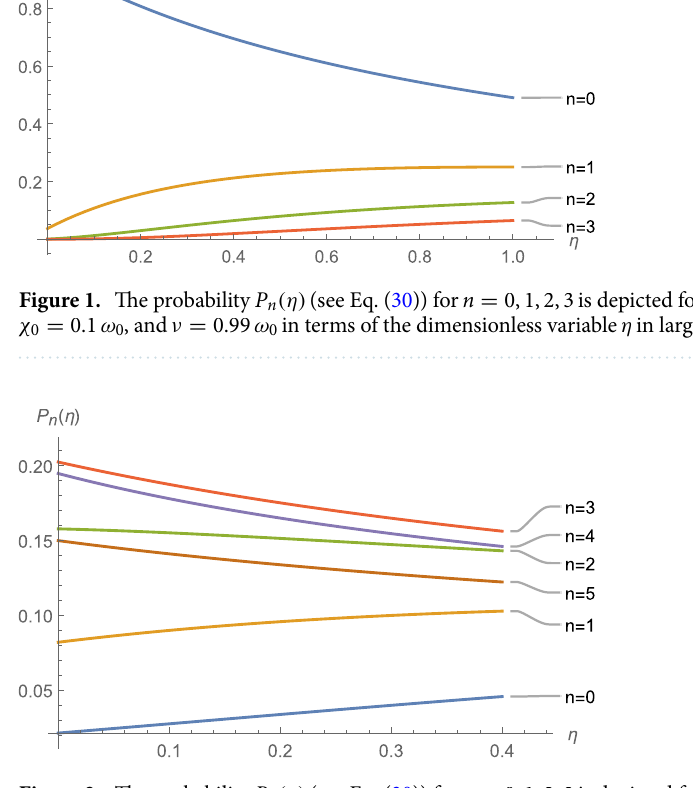
Figure 2. The probability P n (η) (see Eq. (30)) for n = 0, 1, 2, 3 is depicted for the values k 0 = 0.2 ω 0 , χ 0 = 0.1 ω 0 , and ν = 0.99 ω 0 in terms of the dimensionless variable η in large-time